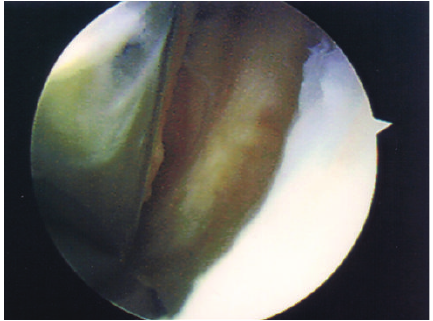
Figure 3: Arthroscopic view of lateral gutter following debride-